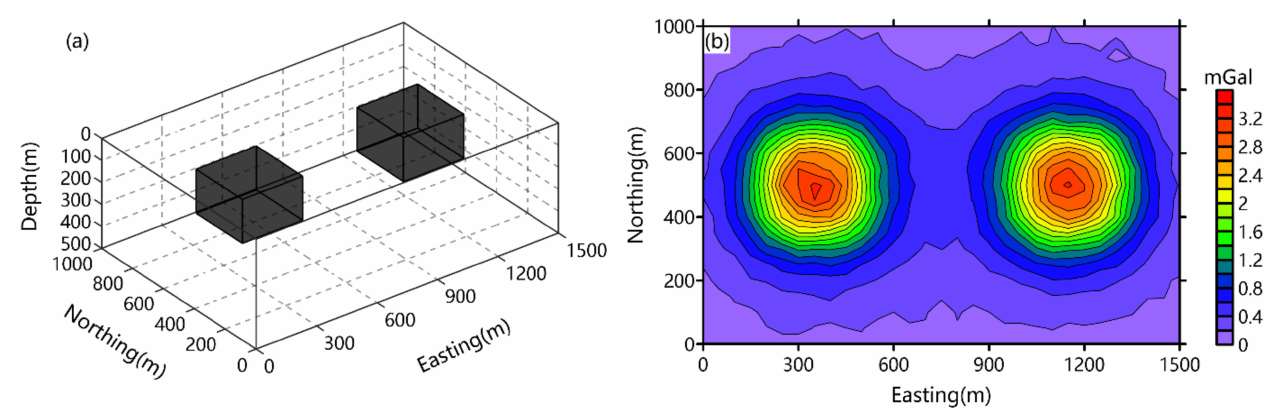
Figure 1. ( a ) 3D perspective view of the model consisting of two cuboids; ( b ) gravity data produced by this